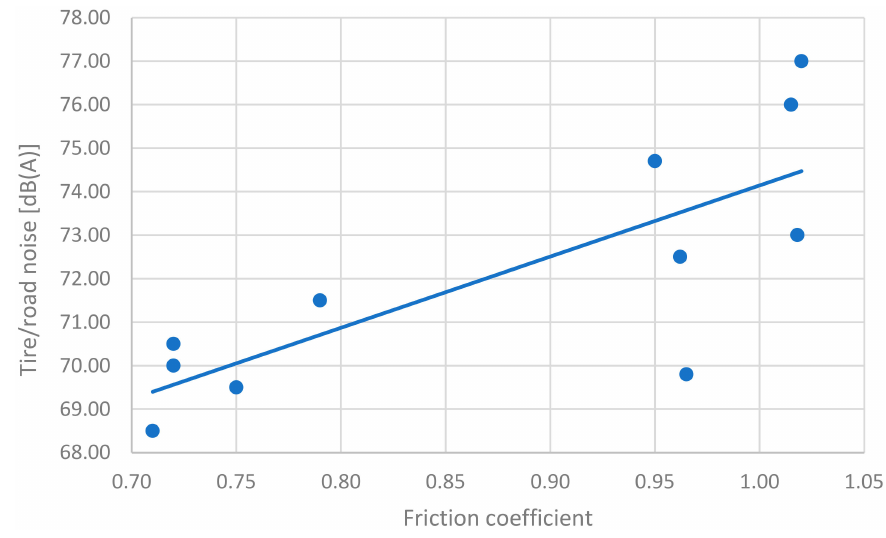
Figure 7. Noise level versus friction coefficient on a dry pavement (adapted from